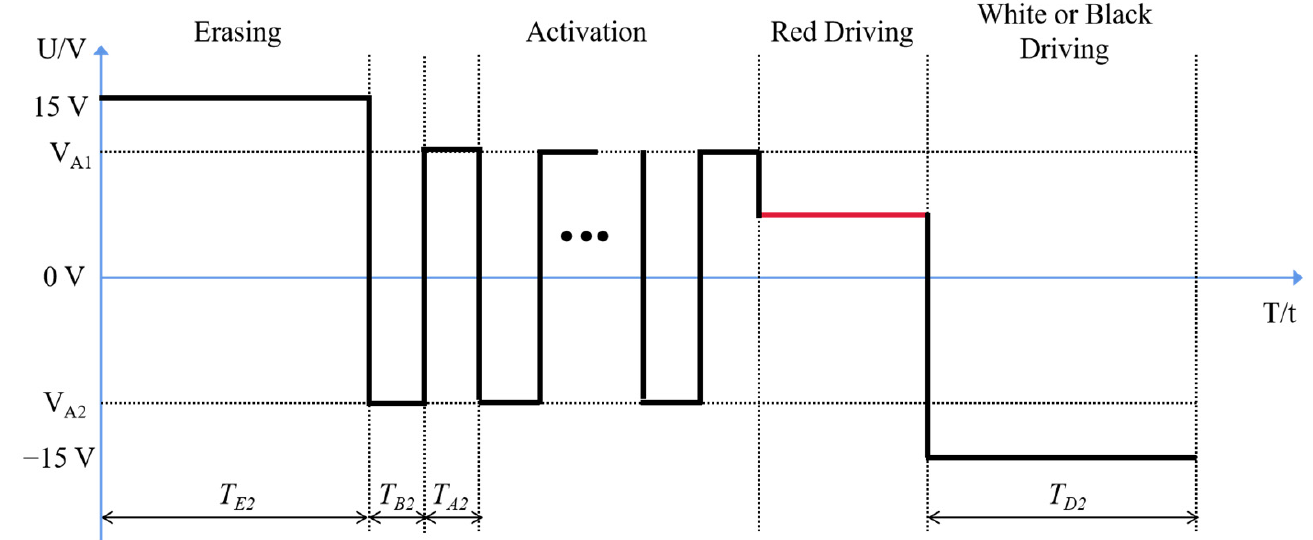
Figure 4. The proposed driving waveform in this paper. It consisted of an erasing stage, an activation stage, a red driving stage, and a white or a black driving stage. T E 2 is the duration of the erasing stage. T B 2 is the duration of negative voltage in one oscillation cycle, and T A 2 is the duration of positive voltage in one oscillation cycle. T D 2 is the duration of the white or black driving stage. V A 1 is the positive voltage of high frequency voltage value. V A 2 is the negative voltage of high frequency voltage value.